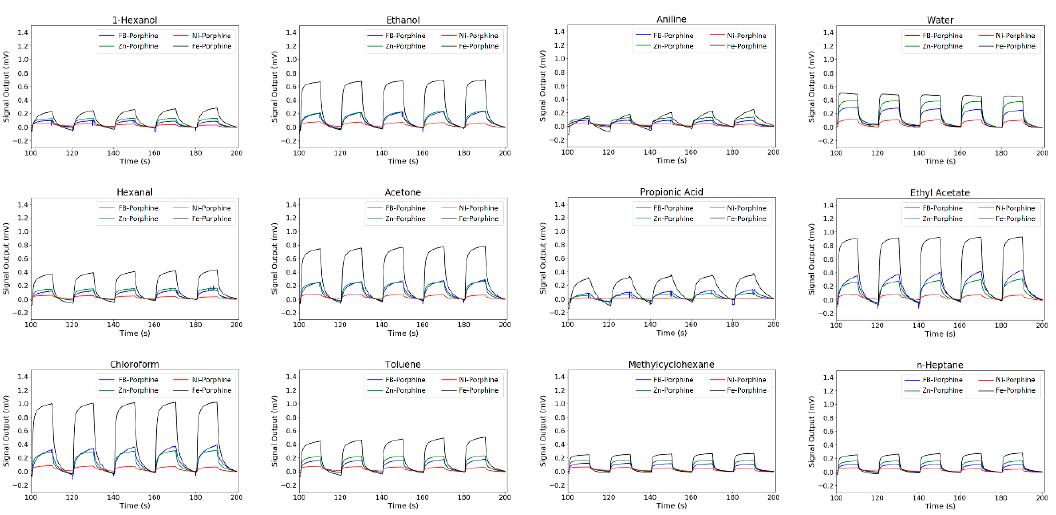
Figure 3. Sensing signals of porphines to gases. The last five cycles of sample gas injection and nitrogen gas purge are shown. Temperature, concentration of gases and relative humidity were 25 °C, 10% in partial vapor concentration and 0% RH, respectively.